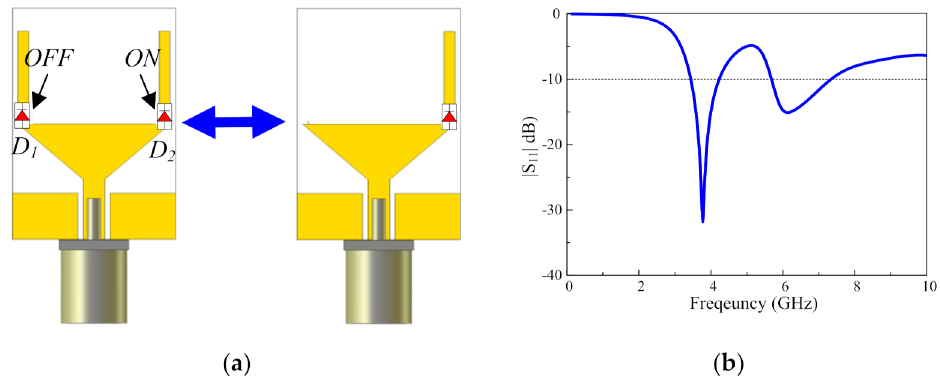
Figure 3. ( a ) Equivalent geometry and ( b ) simulated |S 11 | of the proposed antenna working in dual-band operating mode ( D 1 is OFF and D 2 is